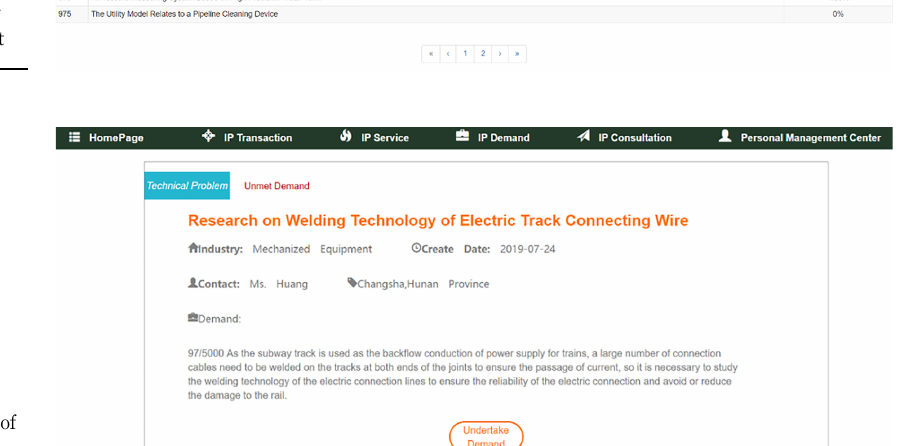
Figure 9. Display interface of patent matching list